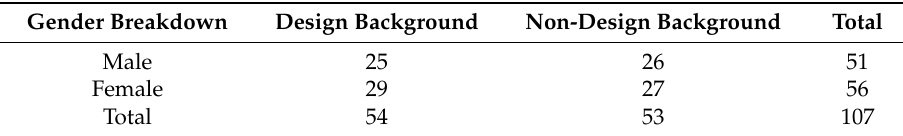
Table 1. Structure of subject samples.